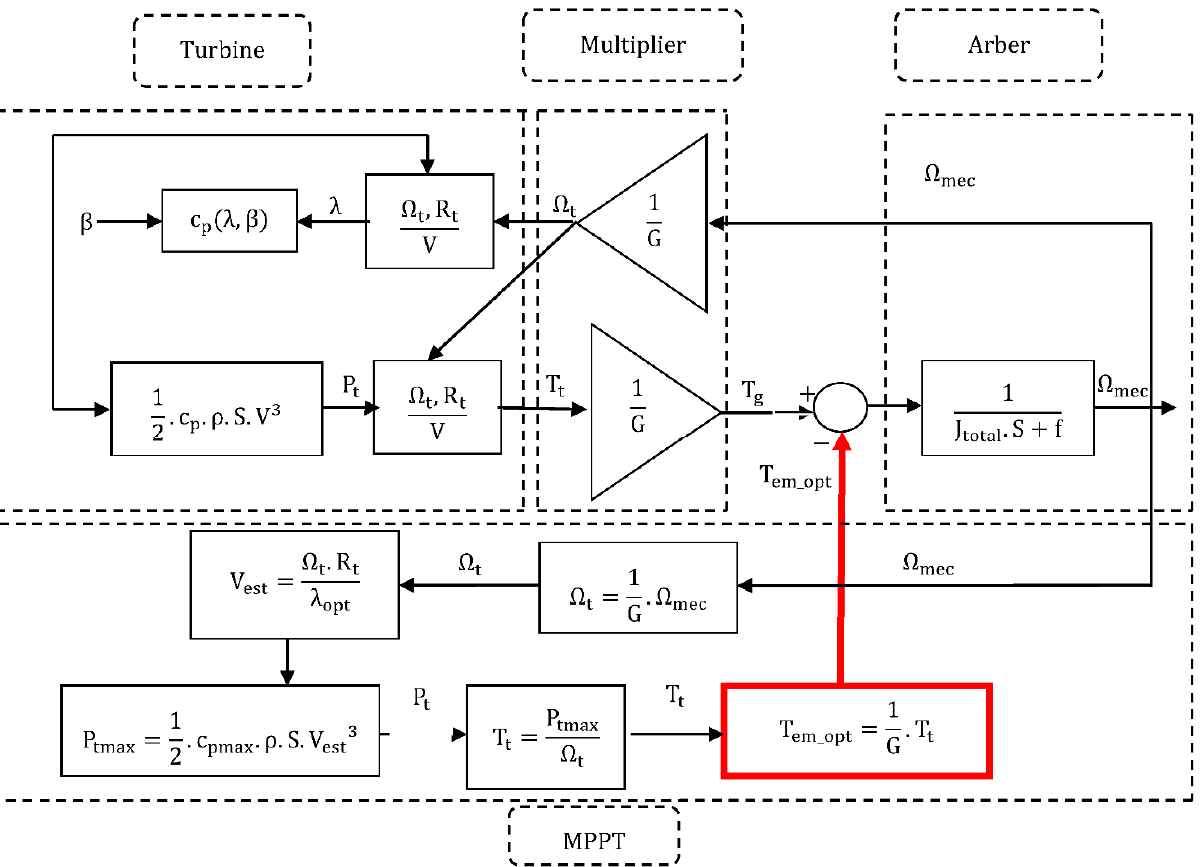
Figure 8. Block diagram of the MPPT power maximization of the wind turbine.